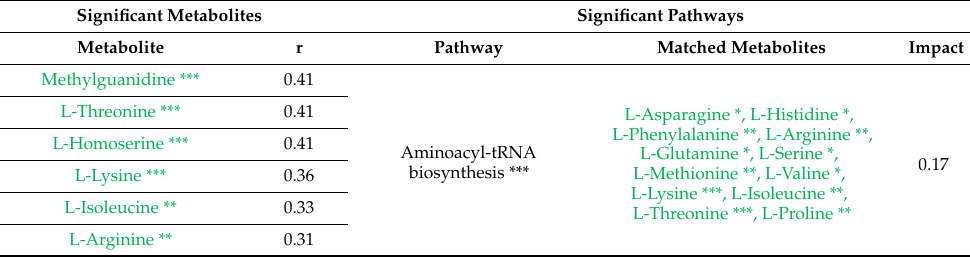
Table 10. Metabolites and their pathways which correlate with methylation